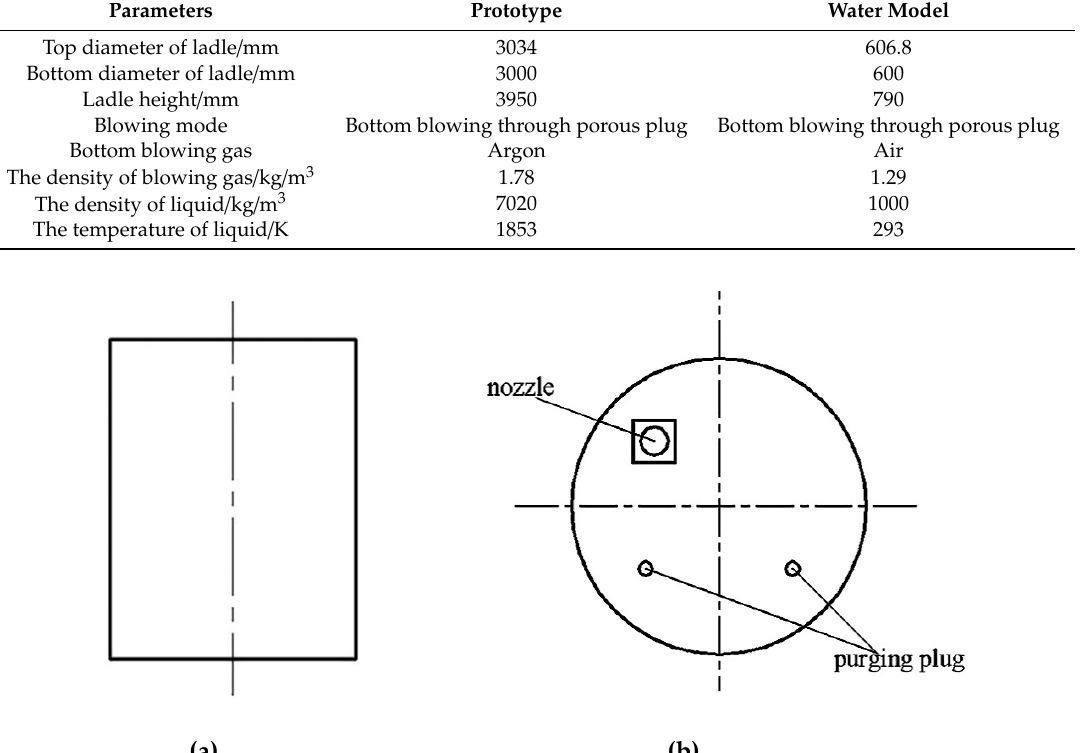
Figure 1. Schematic diagram of the ladle prototype; ( a ) vertical section; ( b ) porous plug arrangement.